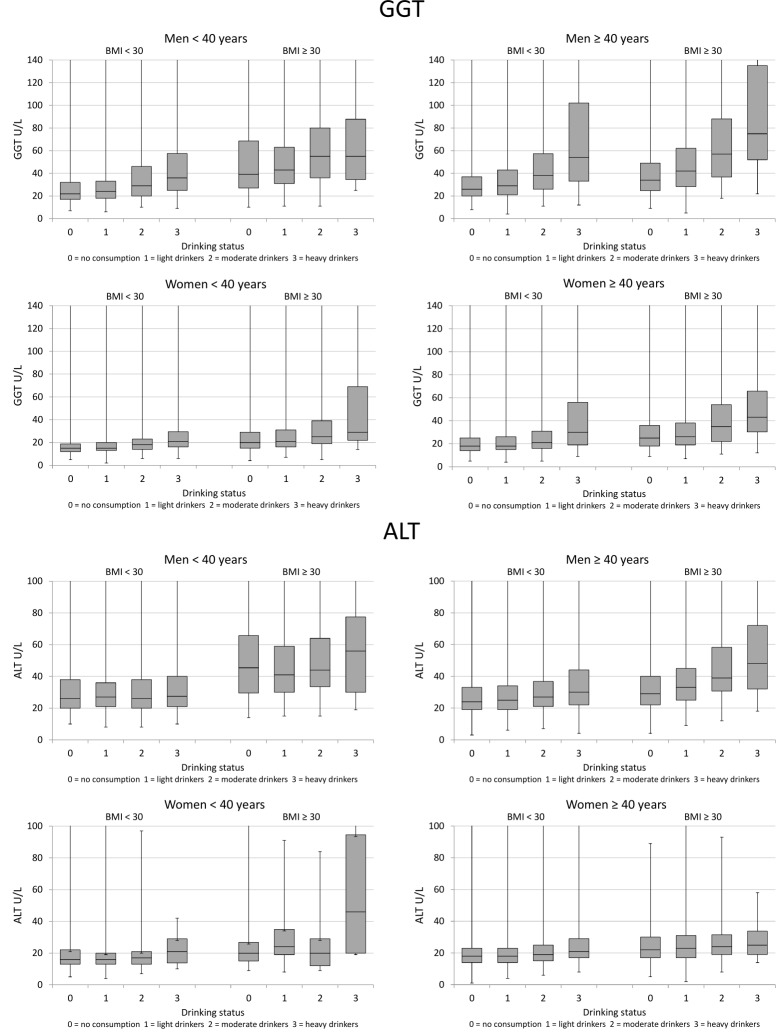
Serum GGT and ALT in subgroups classified according to drinking status, age and BMI.Data are shown as median and interquartile ranges.